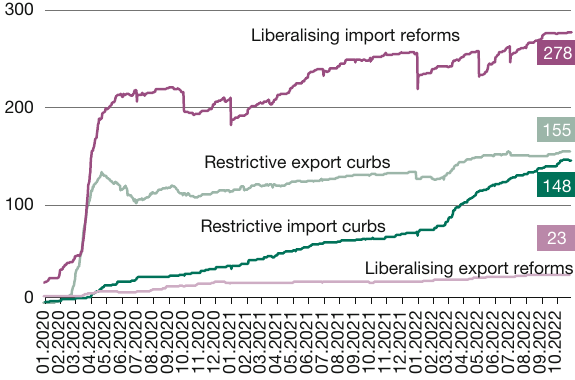
Figure 1 Export curbs on medical goods mushroomed at the start of the COVID-19 pandemic, but more steps were taken to ease sourcing from